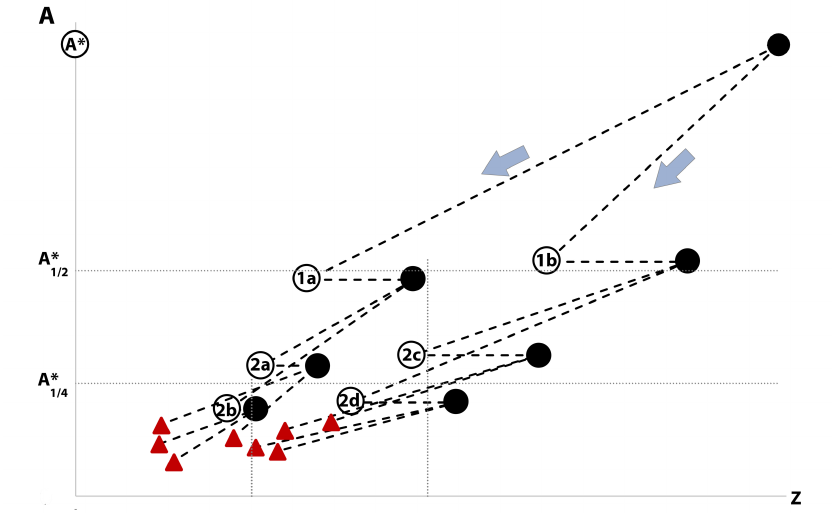
Figure 12. Dispersion in nucleogenetic cascades. For visual simplicity, only fission and β -decays are